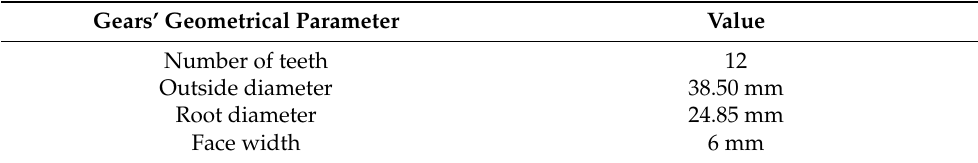
Figure 2. Layout of the pump: ( a ) Three-dimensional transparent view of the case test EGP and its main mechanical components; ( b ) driving gear and driven gear. Table 1. Main geometrical features of the two spur